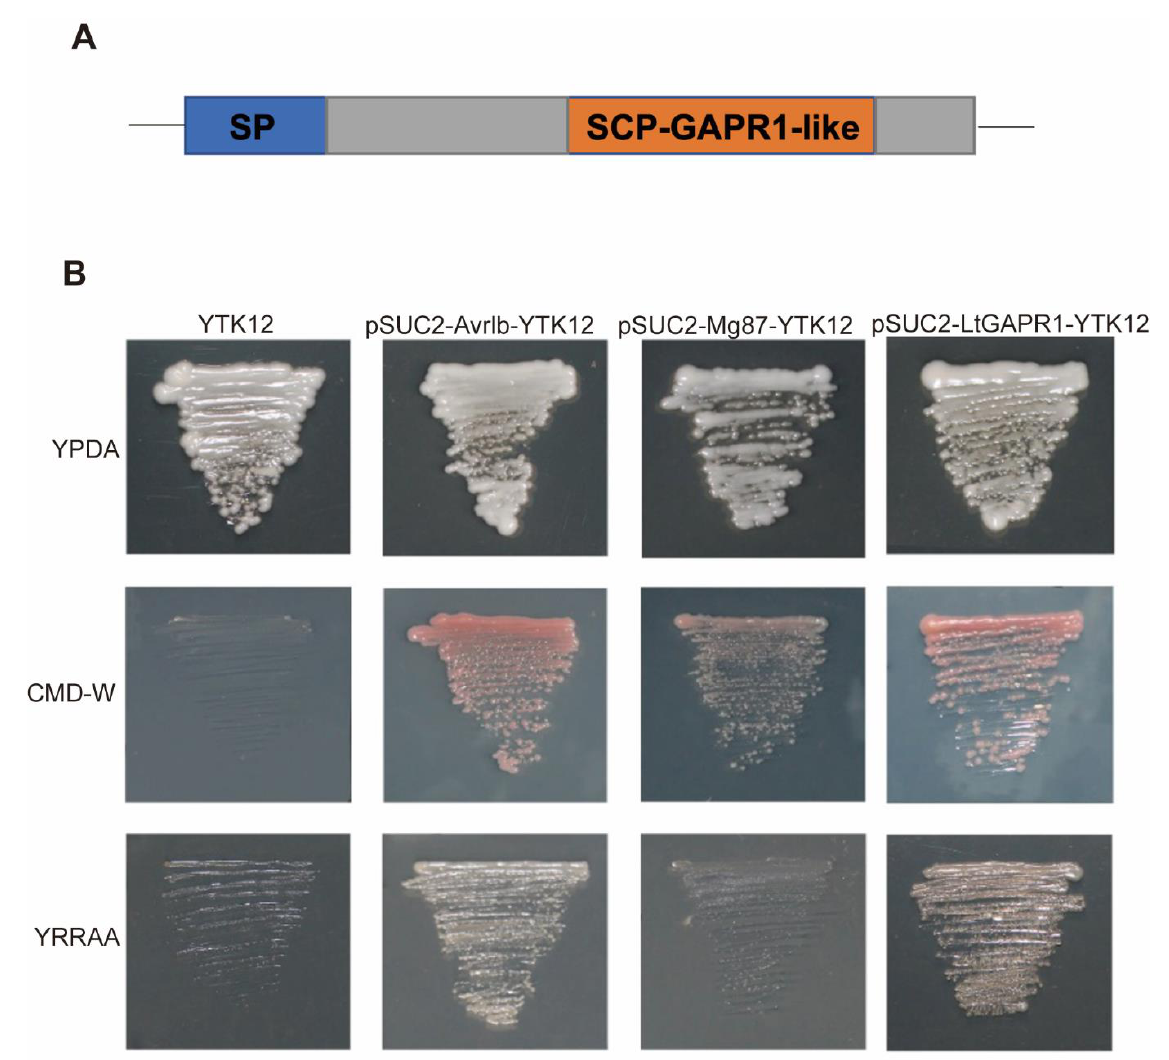
Figure 1. Conserved domain and functional validation of the predicted signal peptide of the L. theobromae , LtGAPR1. ( A ) Conserved domain of LtGAPR1 containing a signal peptide (SP) and SCP-GAPR1 domain. ( B ) Encoding sequence of the predicted signal peptide of LtGAPR1 fused upstream of the invertase gene sequence. Yeast YTK12 transformed with the fusion vectors was grown on YPDA, CMD, and YPRAA media. All yeast strains grew on YPDA. Transformants carrying the pSUC2 fusion vector grew on CMD-W. Only transformants whose invertase was secreted to the extracellular environment grew on YPRAA. YTK12: parental strain; pSUC2-Avrlb-YTK12: positive control; pSUC2-Mg37-YTK12: negative control; pSUC2-x-YTK12: allergen